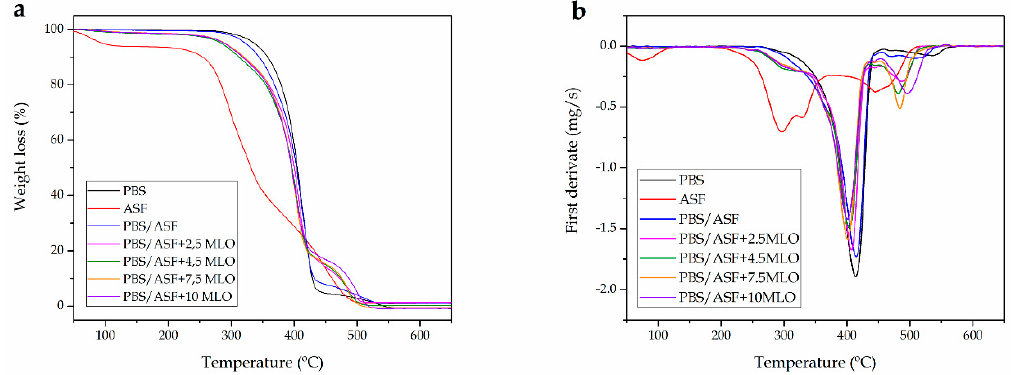
Figure 3. ( a ) Thermogravimetric (TGA) thermograms corresponding to raw ASF, neat PBS and PBS/ASF composites compatibilized with different MLO loading and ( b ) first derivative (DTG) curves.